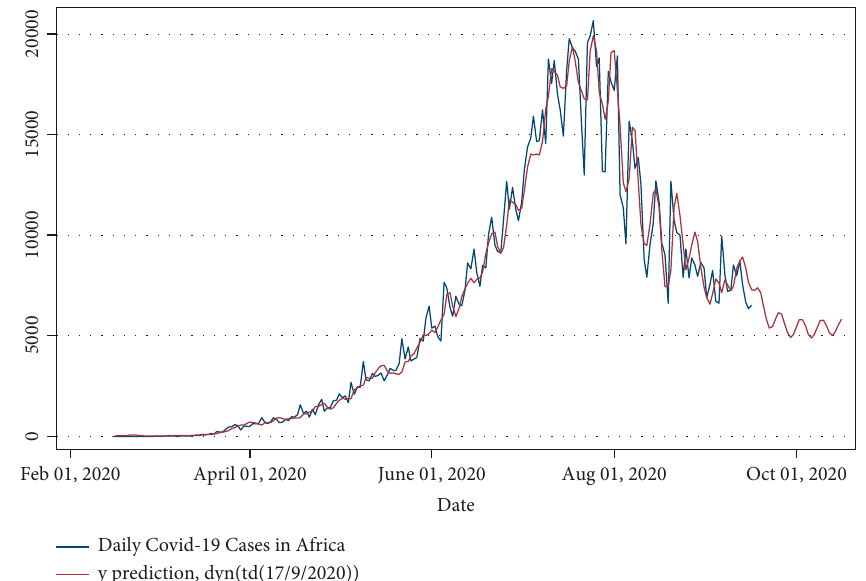
Figure 2: The plot of actual confirmed cases with the prediction result of the ARIMA model for Africa.